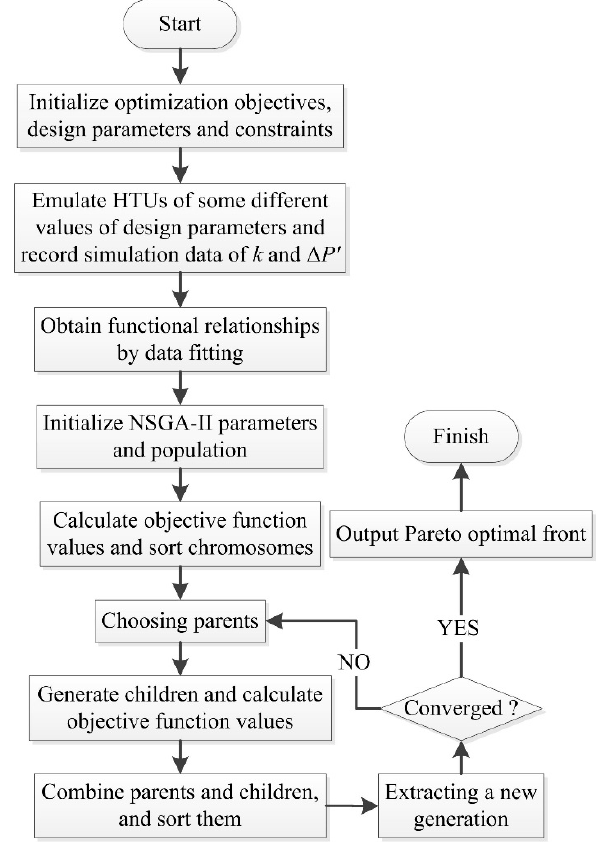
Figure 8. Flowchart of AR configuration optimization method.